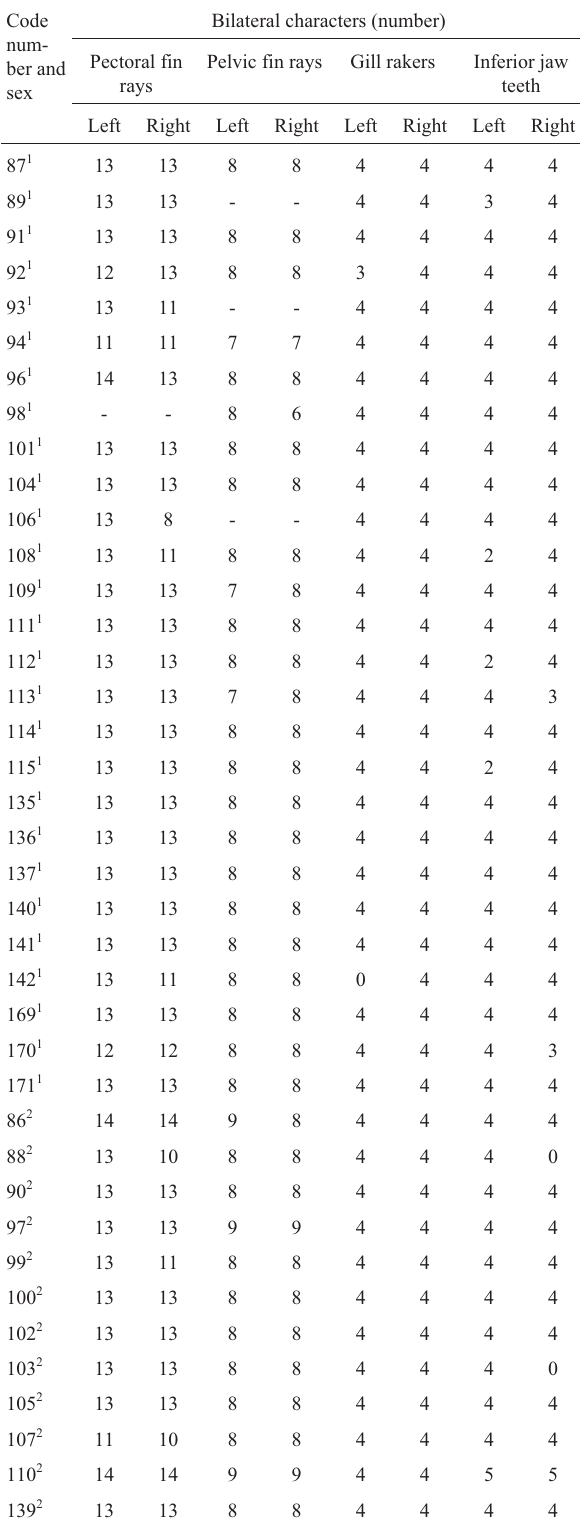
Figure 1 - General view of the sinkhole landscape of Vila Velha State Park (Paraná state, Brazil). Detail shows the two Astyanax phenotypes: a = phenotype I; b = phenotype II. Bar =